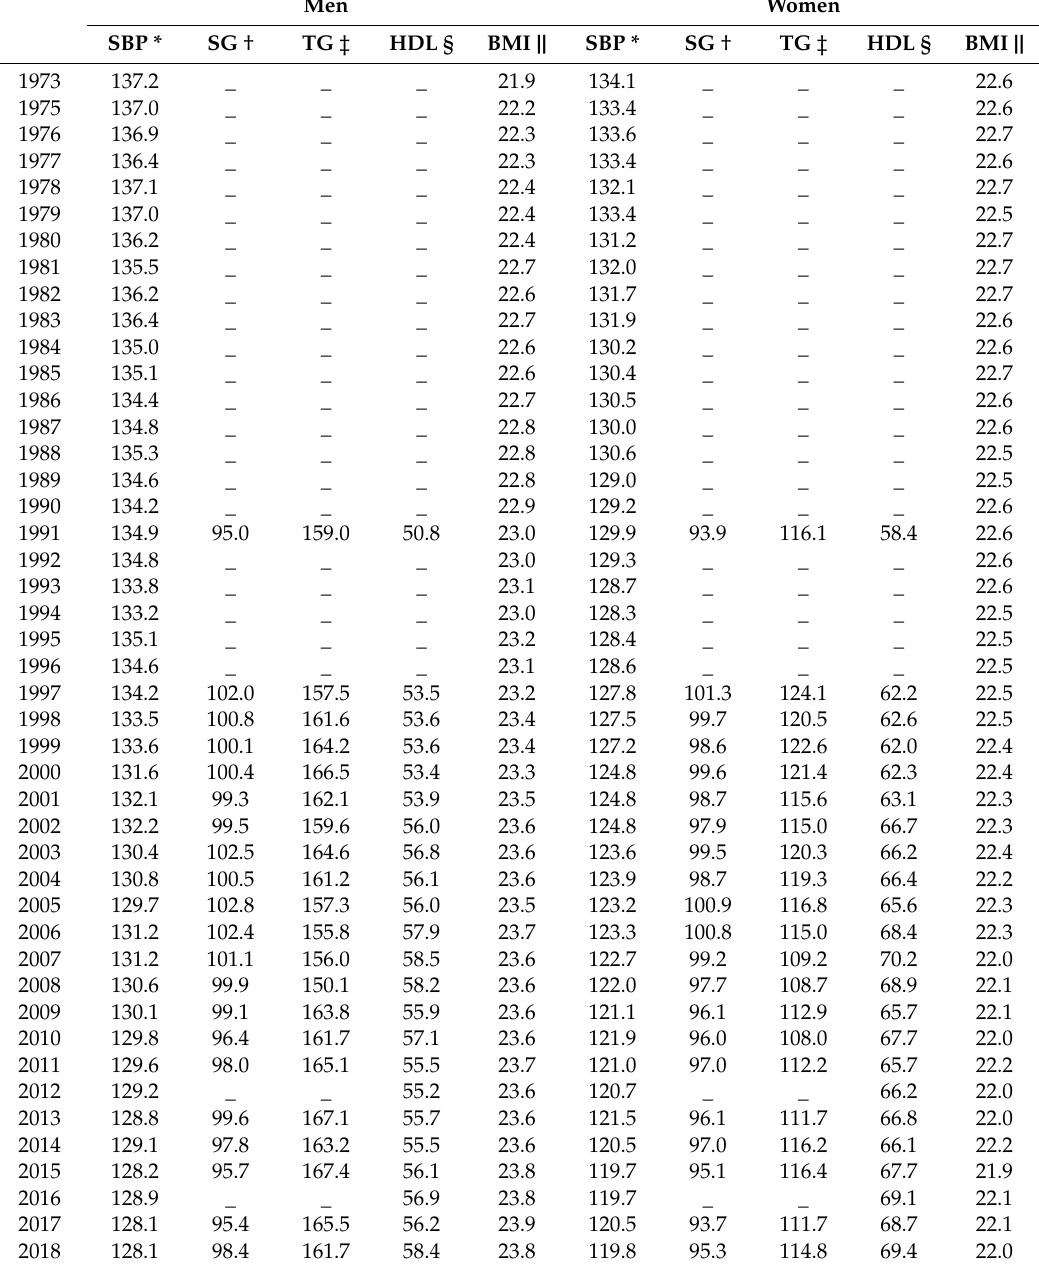
Table 1. Age-standardized laboratory test values for men and women,